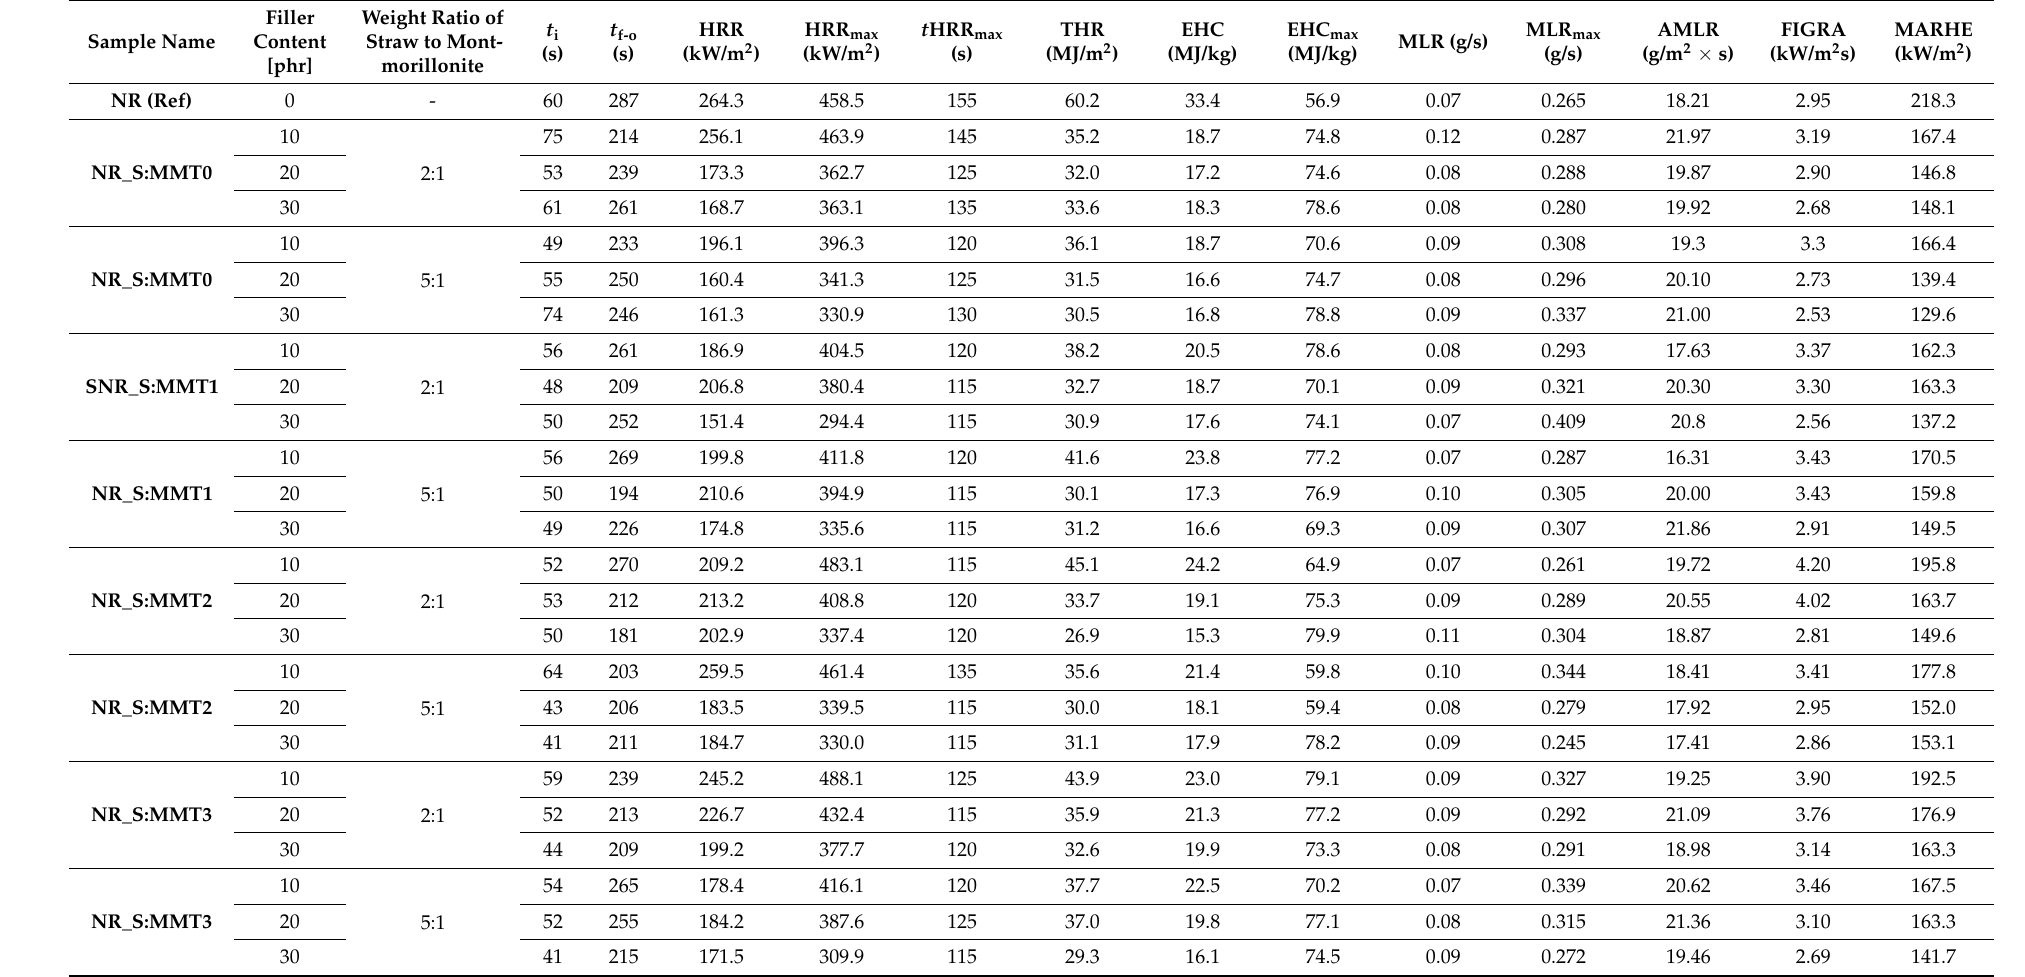
Table 7. Flammability characteristics of